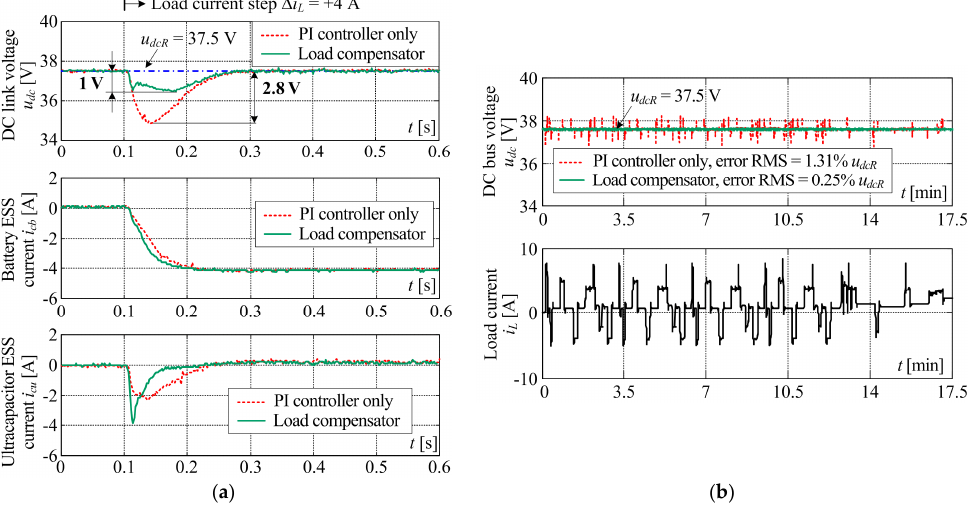
Figure 16. Comparative experimental results of DC bus control system without and with direct feed-forward load compensator: stepwise load change ( a ) and scaled-down NEDC-like load profile ( b ).